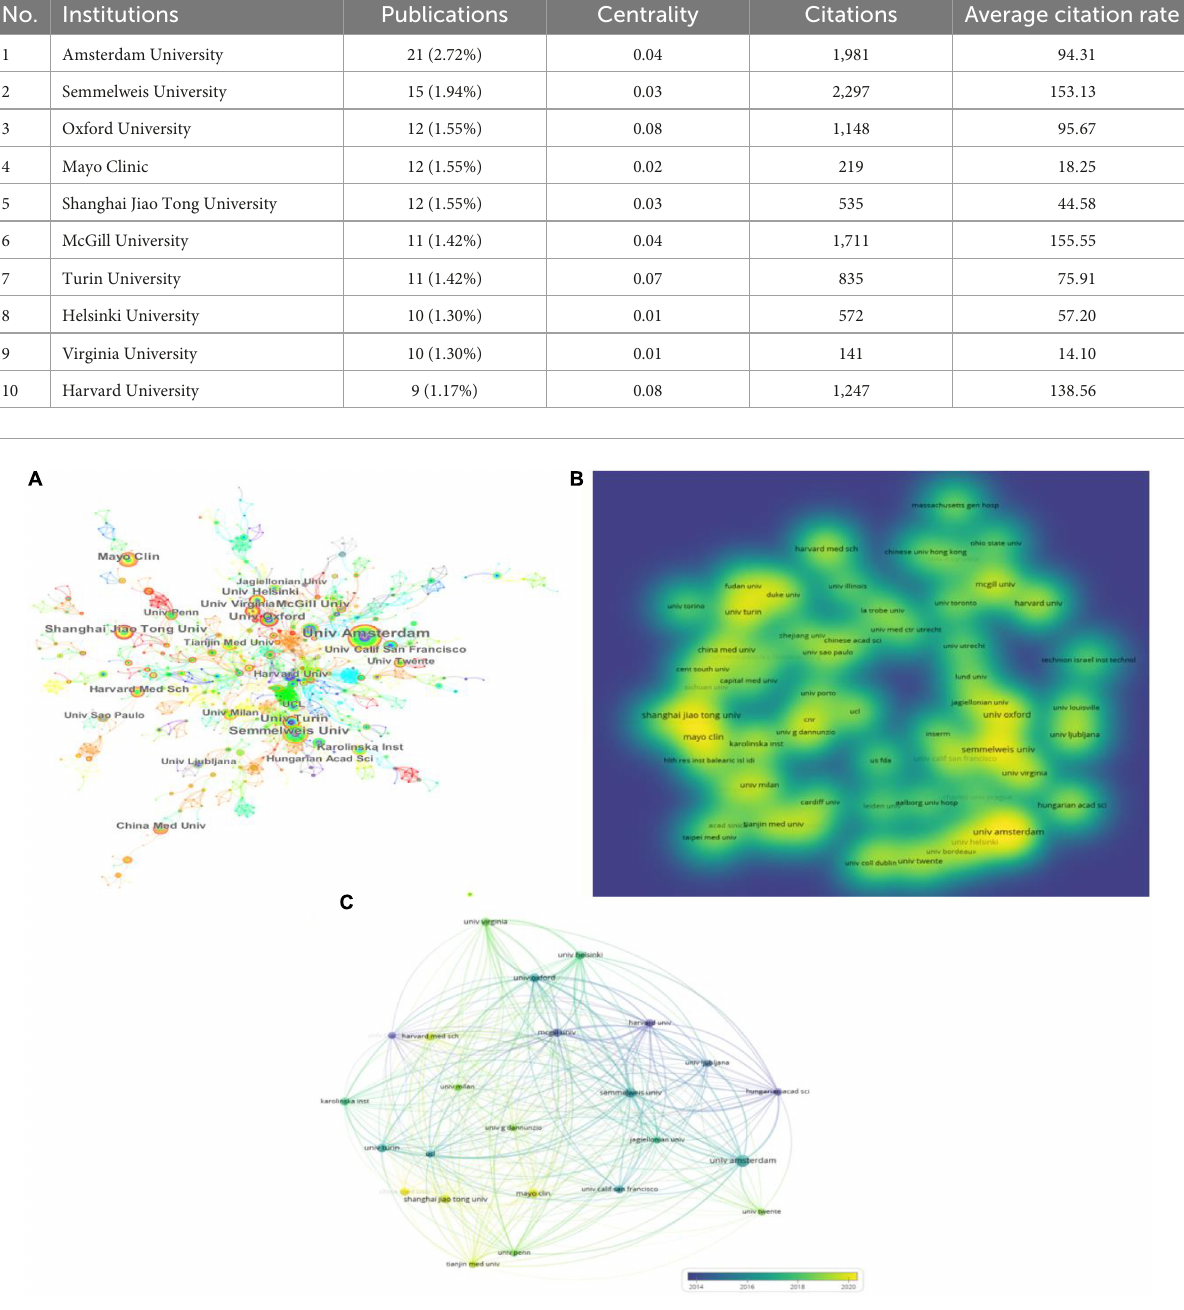
FIGURE3 Institution articles on platelet exosomes. (A) CiteSpace-based interinstitutional collaboration. (B) VOSviewer-based density map of institution distribution. (C) VOSviewer-based institutional temporal.